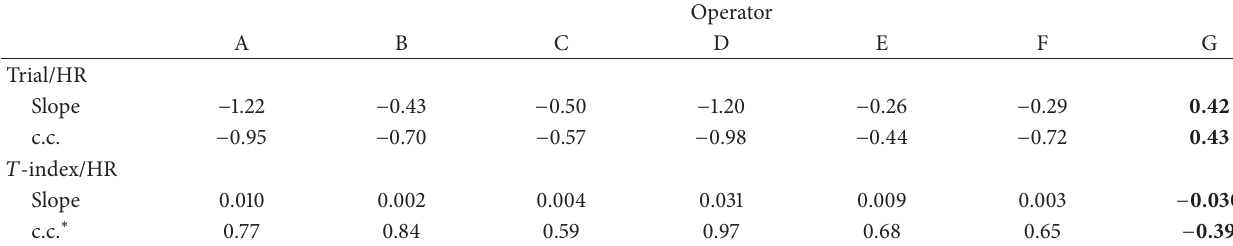
Table 4: Slopes of the regression lines and correlation coefficients in relation concerning HR.